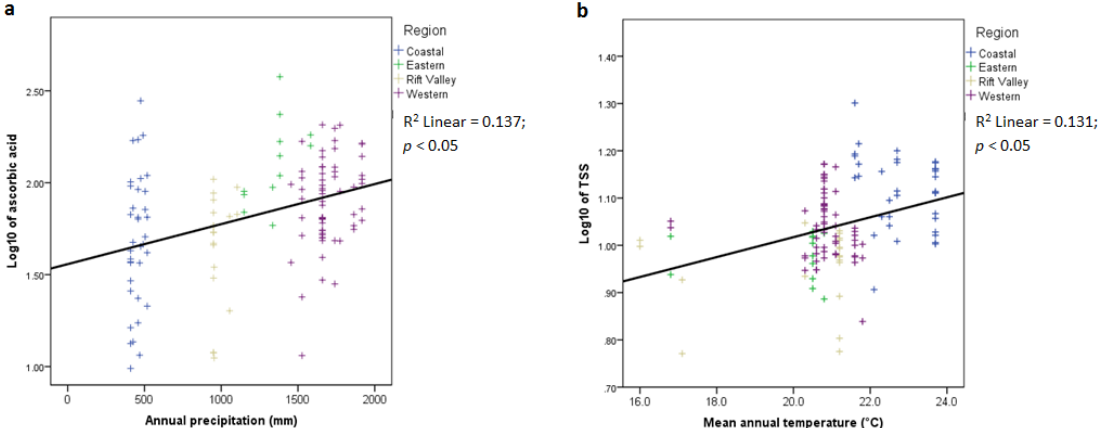
Fig. S2: Pearson correlation between (a) annual precipitation and ascorbic acid content in 128 guava fruit samples from four regions of Kenya, and between (b) mean annual temperature and TSS in 128 guava fruit samples from four regions of Kenya. Ascorbic acid and TSS were determined on extracted juice from edible portion of the fruit.